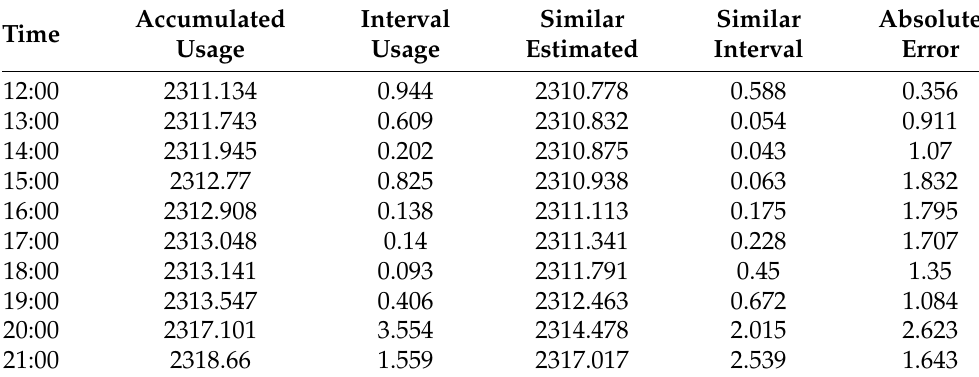
Table 5. Compensation data based on the past-similar-situation substitution